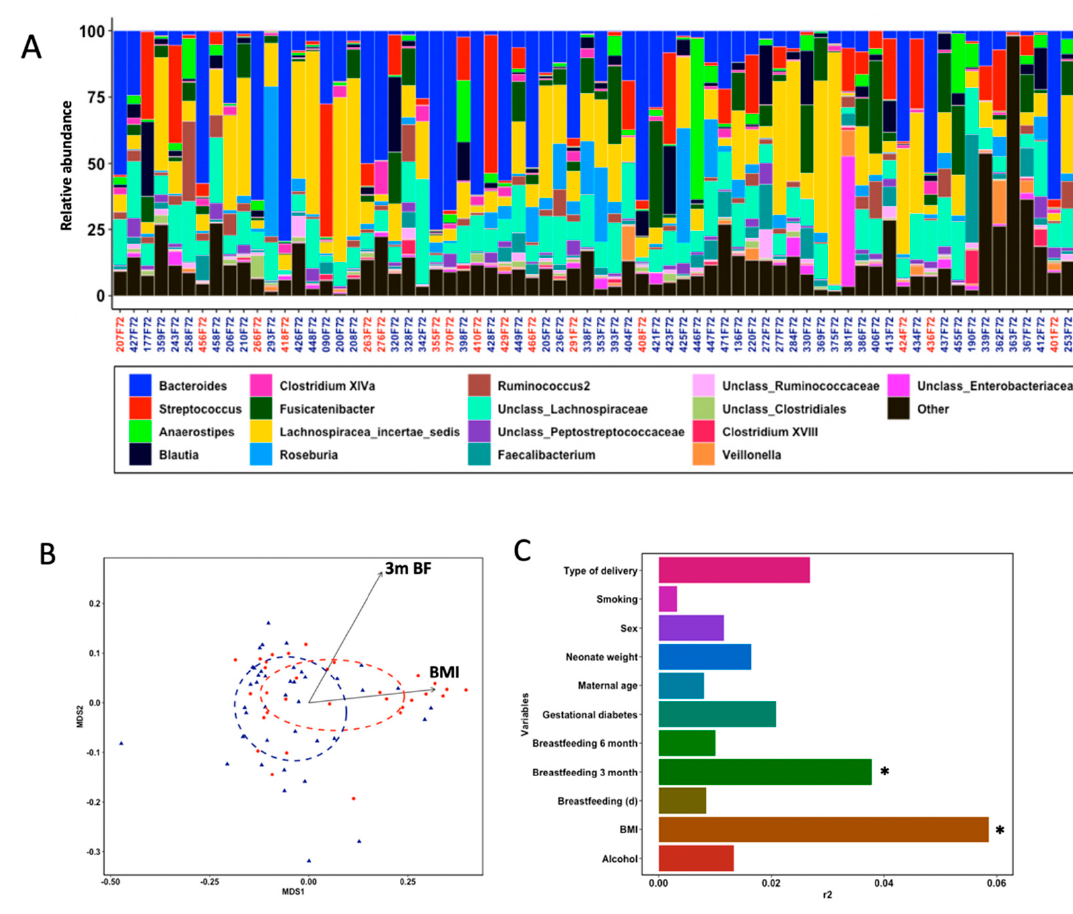
Figure 1. Gut microbial composition and structure in 71 full-term healthy infants at 18 months of age. ( A ) Phylogeny of infants’ gut microbiota at the genus level of 17 core genera detected in ≥ 98% of study subjects. Sample names are coloured according to enterotype: Firm in blue, Bact in red. ( B ) Scatterplot from principal coordinate analysis using weighted Unifrac metrics in above-median (blue) and below-median (red) fine motor groups. Additional significant explanatory variables are represented by black arrows originating from the coordinate system origin. ( C ) Horizontal bars show the influence of anthropometric, maternal and nutritional variables (r 2 ) on gut microbiota composition. * p < 0.05 for PERMANOVA test with 999 permutations.